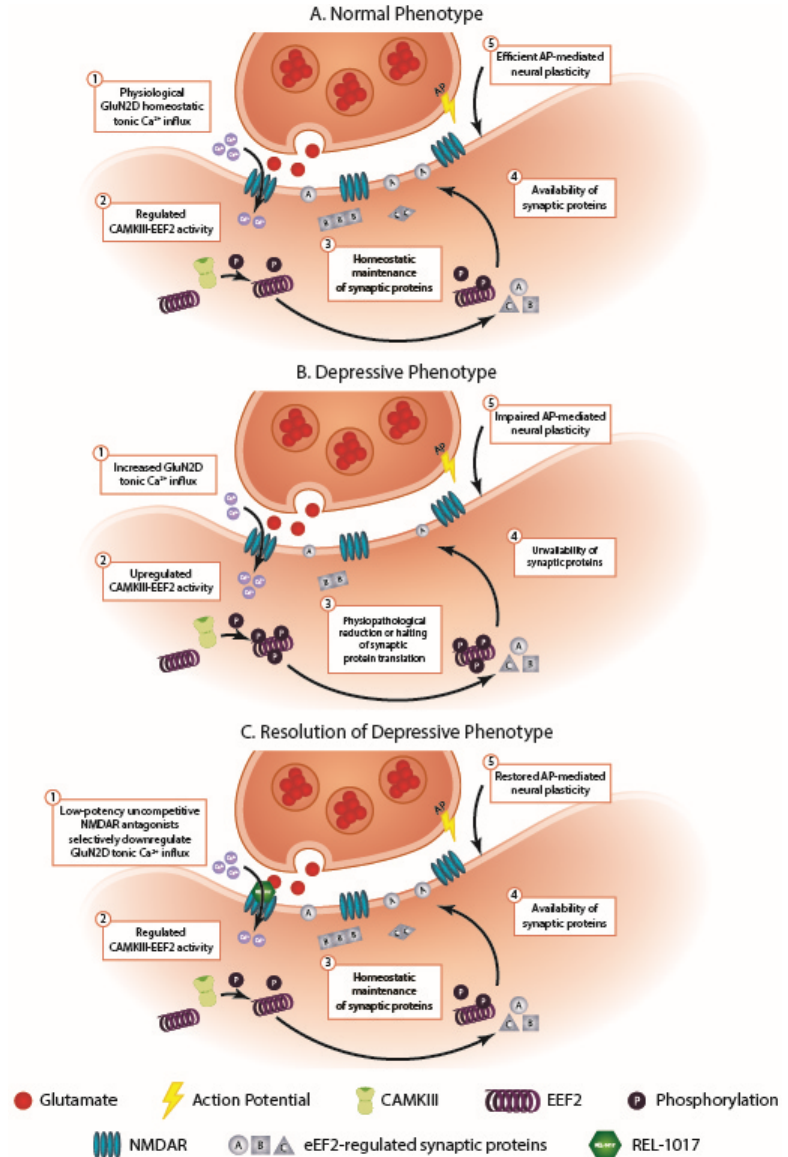
Figure 1. Proposed mechanism of kinase involvement in uncompetitive NMDAR antagonist-mediated rapid antidepressant effects. ( A ) In the normal phenotype, physiological GluN2D homeostatic tonic Ca 2+ influx appropriately regulates CAMKIII phosphorylation of EEF2, which results in adequate homeostatic maintenance and availability of synaptic proteins required for action potential (AP)-mediated neural plasticity. ( B ) In the depressive phenotype, increased Ca 2+ influx through GluN2D channels upregulates CAMKIII-EEF2 activity, leading to the halting of synaptic protein production and availability, resulting in impaired AP-mediated neural plasticity. ( C ) Resolution of the depressive phenotype is possible through the action of uncompetitive NMDAR antagonists, such as REL-1017, which block excessive tonic Ca 2+ currents, restoring the homeostatic maintenance and availability of synaptic proteins, thereby enabling physiological AP-mediated synaptic